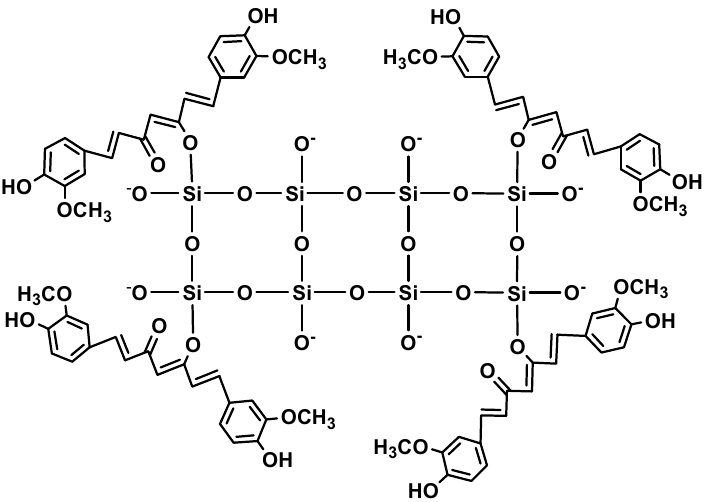
Figure 2. Curcumin-bound mesoporous silicon